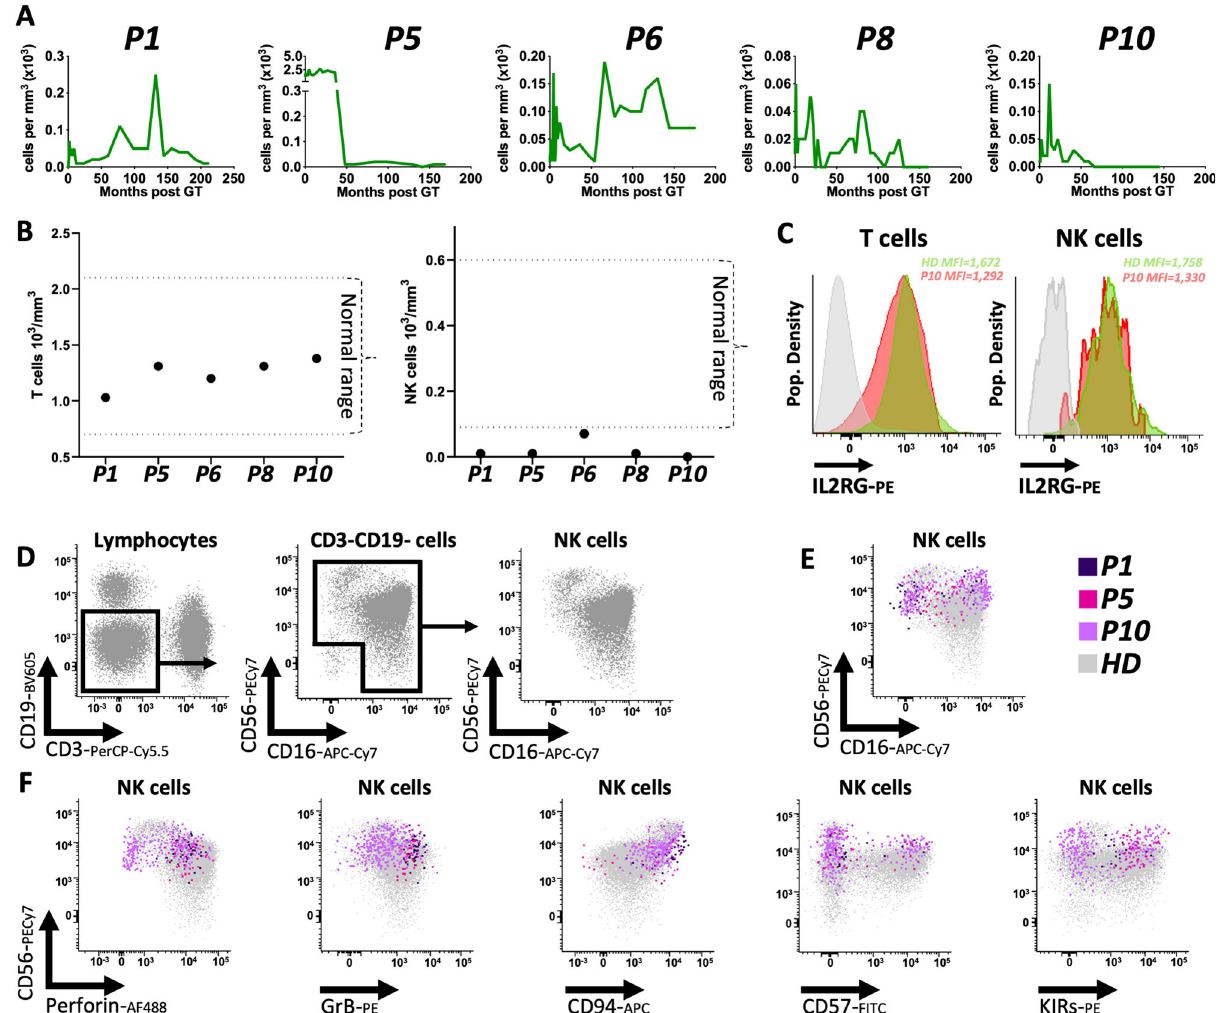
Fig. 6 Analysis of peripheral blood contribution and immunophenotype of NK cells. A Absolute counts of NK cells overtime in P1, P5, P6, P8 and P10. B Comparison of absolute counts of T (left plot) and NK (right plot) cells in patients (black dots) as measured at the latest available timepoint vs. normal ranges measured in healthy age matched individuals (dotted lines). C FACS plots showing the γ chain expression in T cells and NK cells in patient 10 (red) and a healthy donor (green). Isotype control is shown in grey. D FACS plots showing the gating scheme for the identi fi cation of NK cells within the lymphocyte population of a healthy donor used as reference. E Overlayed FACS plot showing the expression of CD56 and CD16 on NK cells in HD, PT1, P5 and P10. F Comparison of expression of Perforin, Granzyme B (GrB), CD94, CD57 and Killer-cells immunoglobulin-like receptors (KIRs) between a representative HD vs. P1, P5 and P10 inside the NK cells